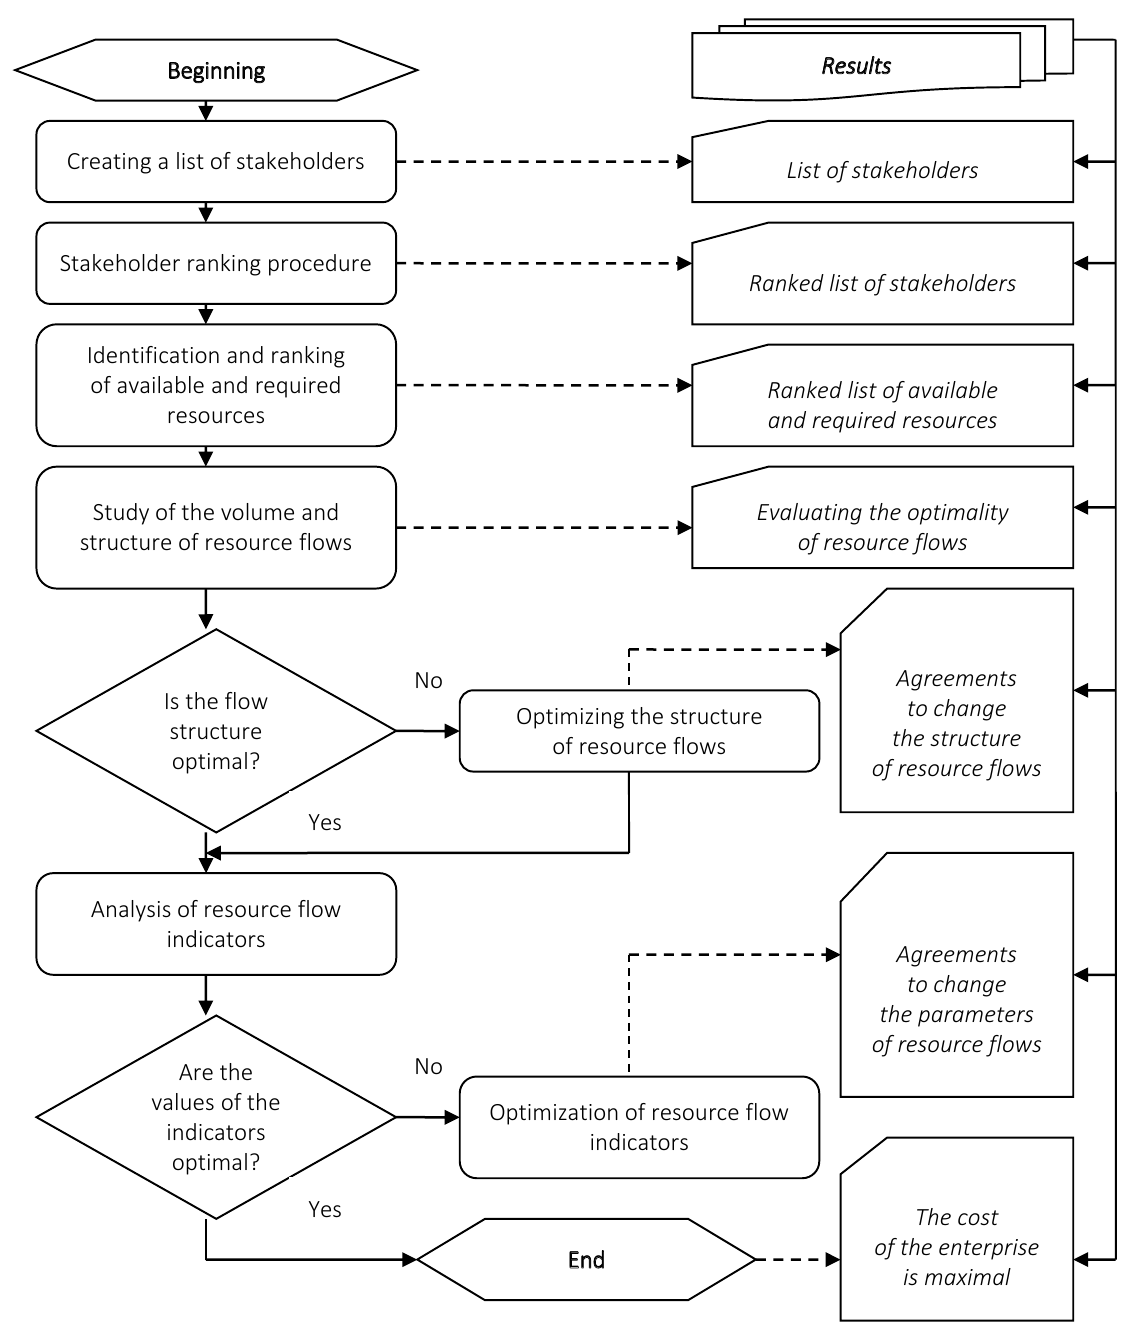
Figure 1. Algorithm of enterprise value management based on stakeholder